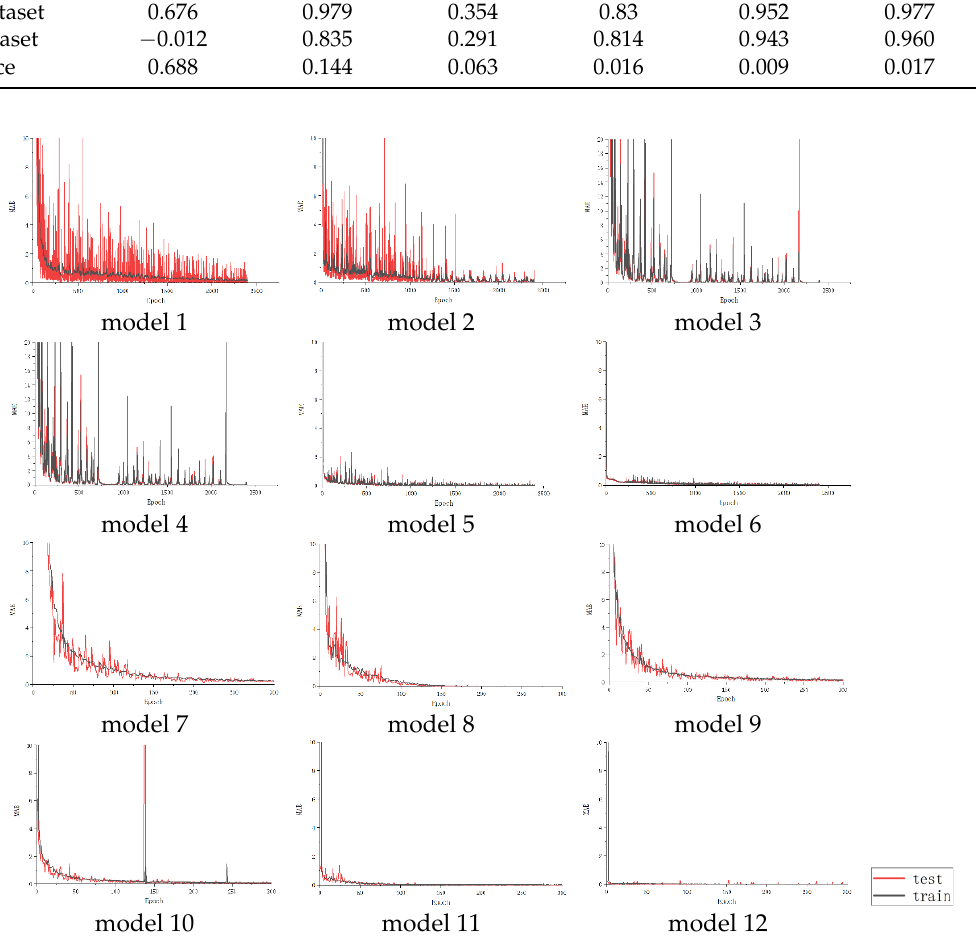
Figure 10. Calculation of each model (epoch R2 score). Table 8. Performance of Group A models at 2500 epochs.